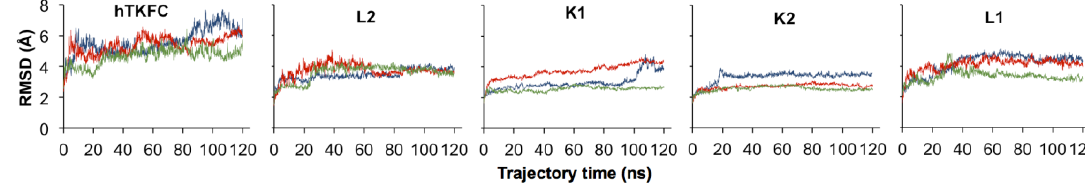
Figure 6. Root-mean-square deviations (RMSD) of C α atoms during molecular dynamics simulation of hTKFC and its complexes with kinase or cyclase substrates. Distances were calculated relative to their initial positions in the structural models prepared. The different panels show, as indicated, the RMSD values calculated for the full protein or for each protein domain separately. The colored traces correspond to (blue) apo-hTKFC, (red) hTKFC:2DHA:2ATP and (green) hTFKC:2FAD. Each system was first submitted to an energy-minimizing and equilibration process, upon which the trajectory production phase was started. At time zero the three systems differed from the initial ones with C α RMSD values of 2.57 Å, 2.39 Å and 2.56 Å, respectively.